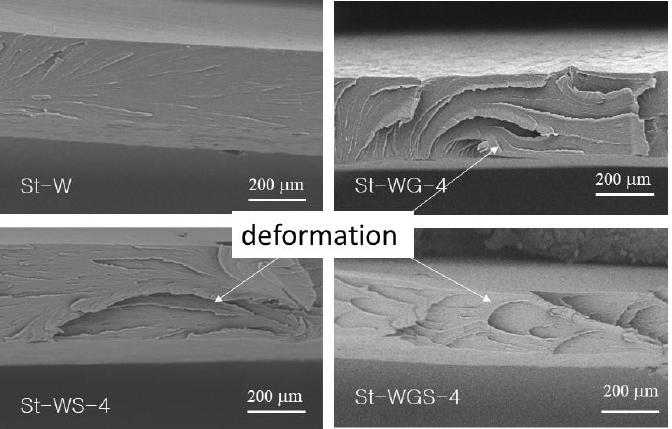
Figure 1. SEM image of the fracture surface of starch-based films containing different plasticizers.